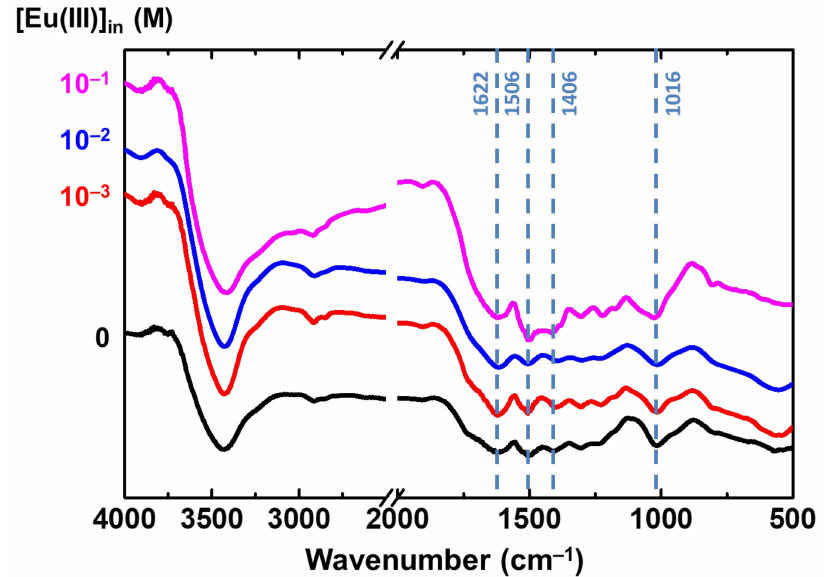
Figure 3. FTIR spectra of X-alginate aerogel beads (black line) and dried X-alginate beads after sorption of different amounts of Eu(III) (colored lines) from solutions with different initial Eu(III) concentrations (10 − 3 –0.1 mol L − 1 , as